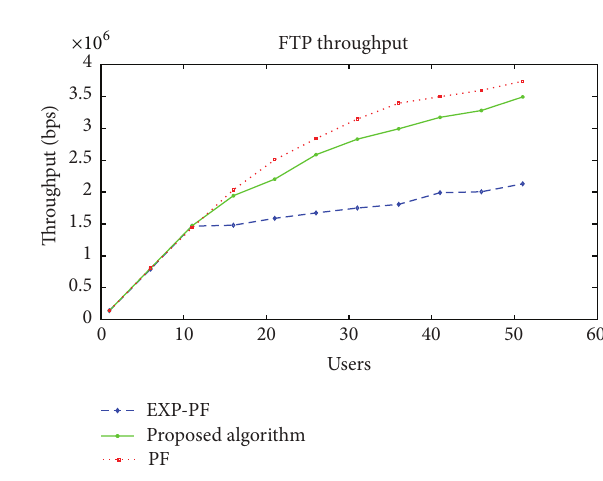
Figure 9: FTP packet loss ratio.